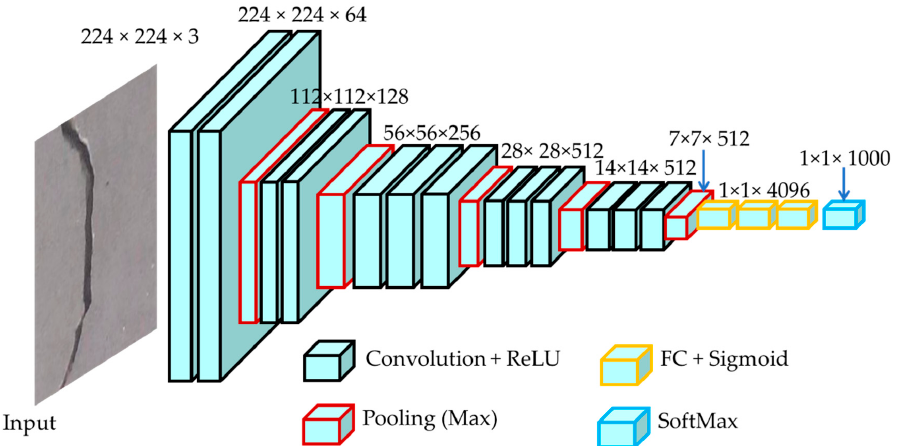
Figure 2. The proposed encoder framework using the visual geometry group network (VGGNet) architecture with some modification. In the figure, ReLU stands for the rectified linear unit, and FC defines the fully connected network.